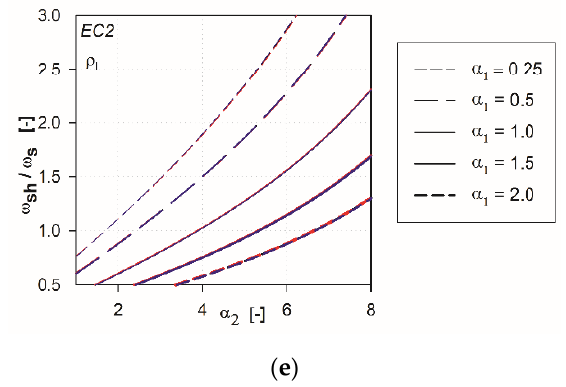
Figure 5. Independent variables impact on the results of the analysis: ( a ) and ( f ) column dimension; ( b ) and ( g ) slab height; ( c ) and ( h ) slab span; ( d ) and ( i ) reinforcement cover; ( e ) slab reinforcement ratio.